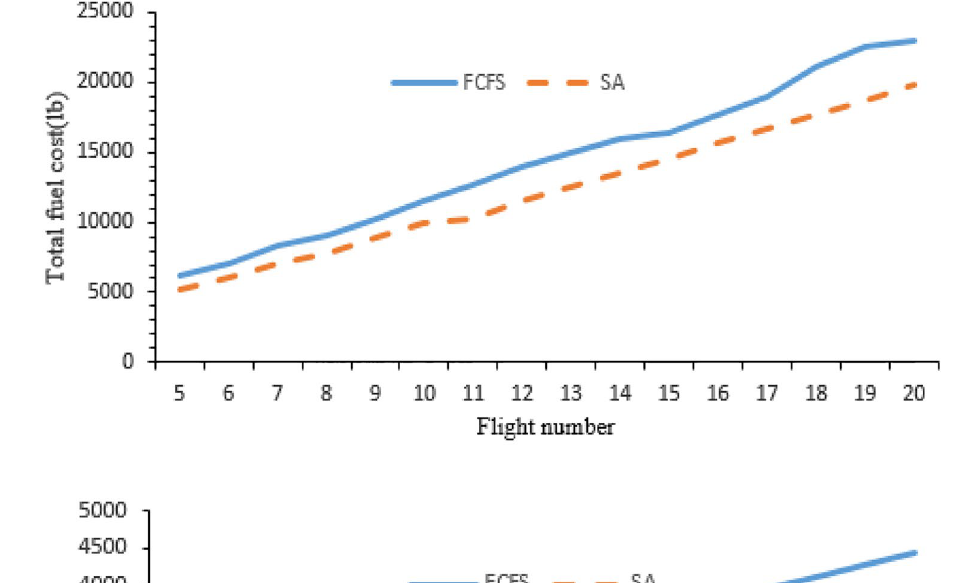
Fig. 6 The total fuel cost of FCFS and SA